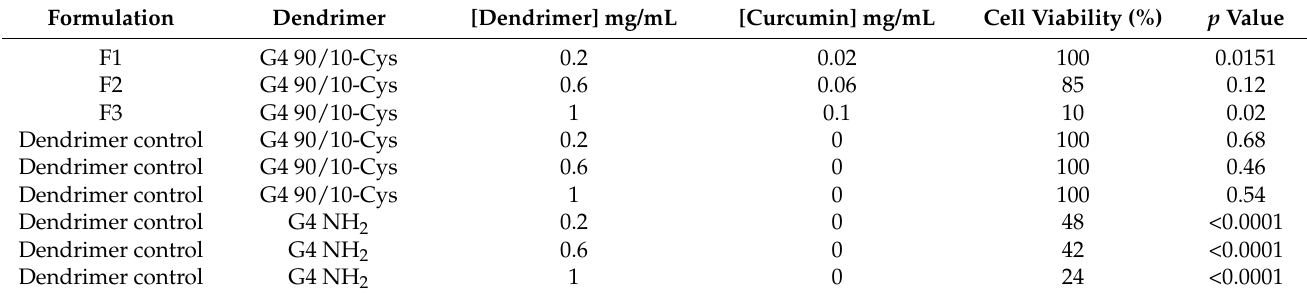
Table 3. Effect of F1, F2 and F3 on control HEK 293 cells.